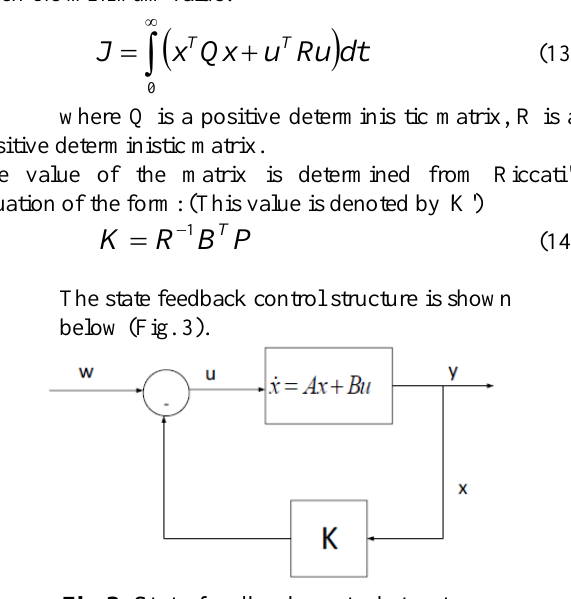
Fig 3. State feedback control